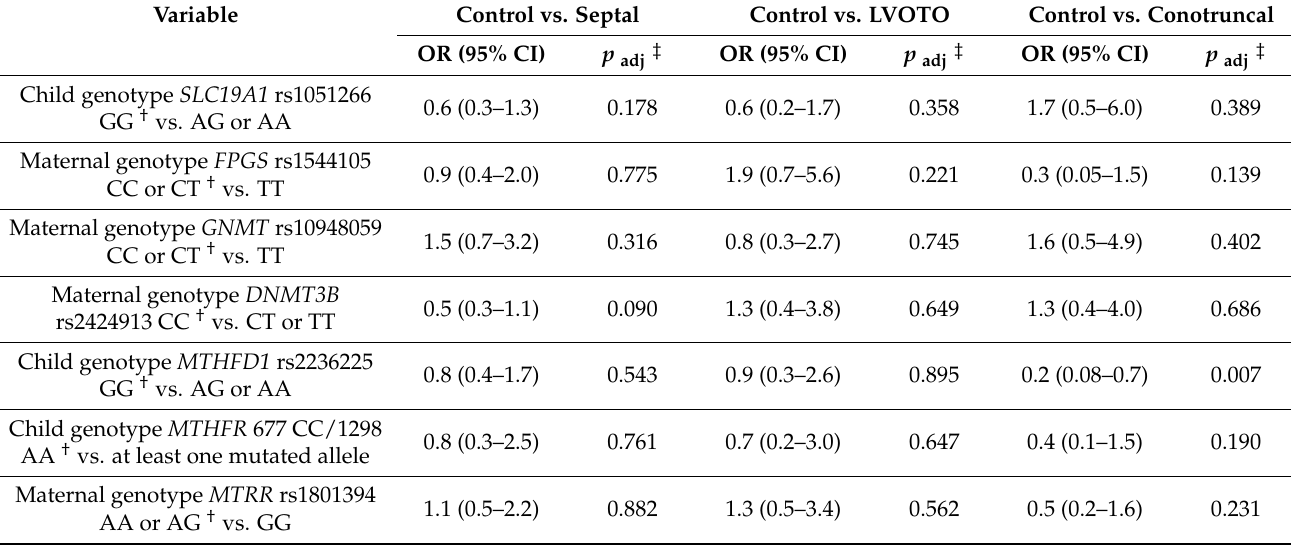
Table 3. Multinomial logistic regression models of maternal and children‘s selected genetic risk fac- tors in control and CHD sub-groups (septal, left ventricular outflow tract obstruction [LVOTO], and conotruncal). LVOTO, left ventricular outflow tract obstruction; OR, odds ratio; CI, con- fidence interval; SLC19A1 , solute-carrier family 19; FPGS , folypolyglutamyl synthase; GNMT , glycine N-methyltransferase; DNMT3B , DNA (cytosine-5-)-methyltransferase 3 beta; MTHFD1